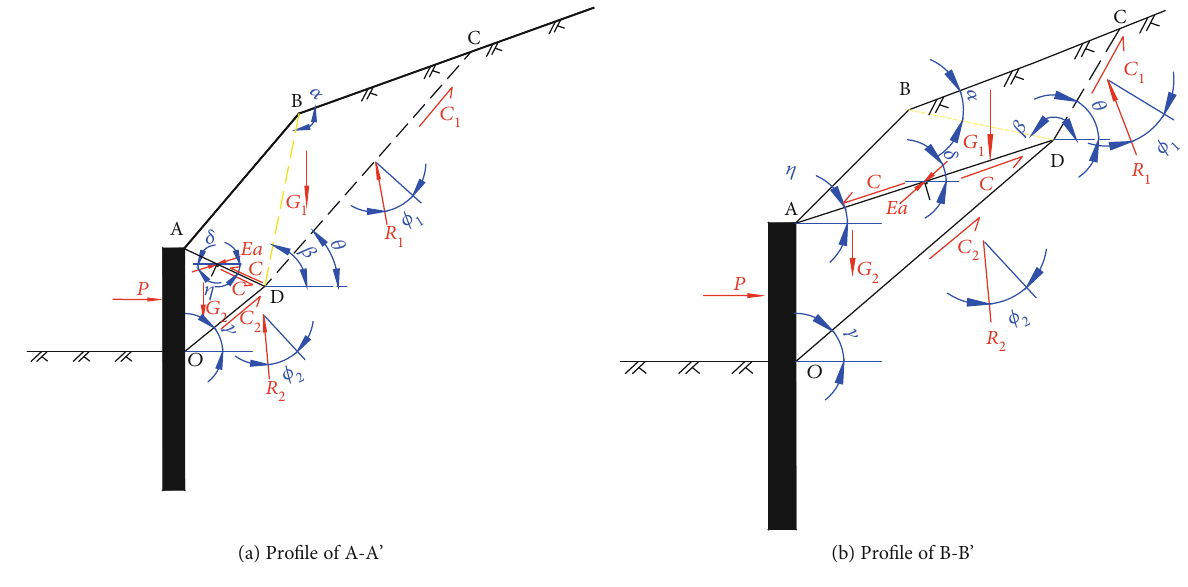
Figure 9: Mechanical analysis of rock mass and soil behind antipiles. Table 2: Physical and mechanical parameters of rock mass, soil, and materials.